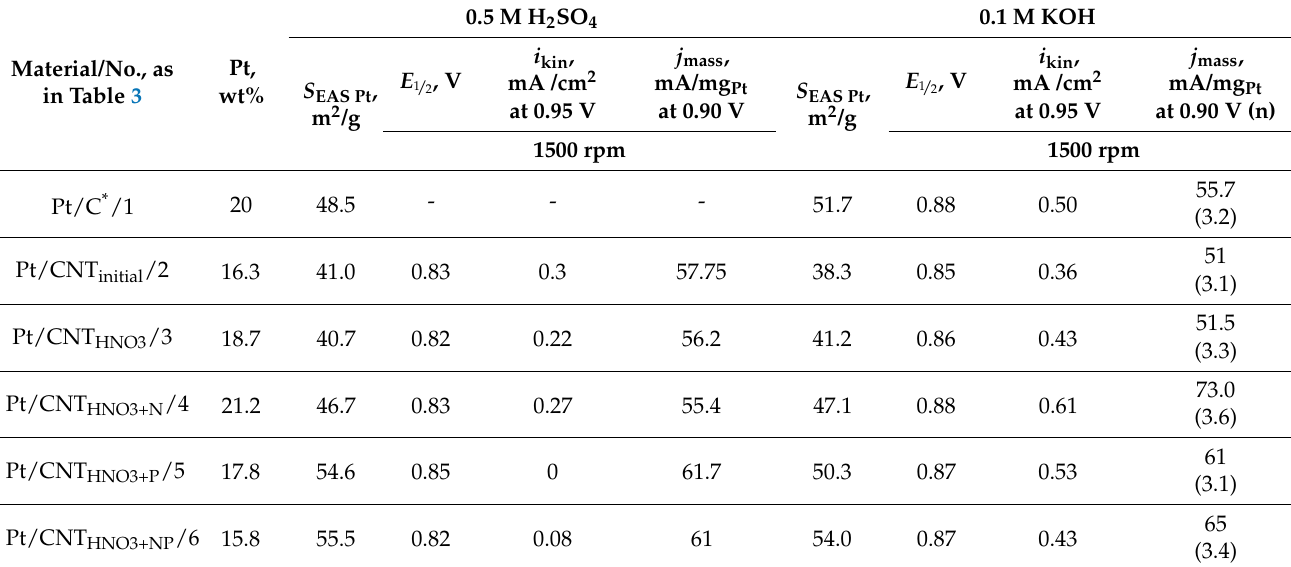
Table 4. Electrochemical characteristics of monoplatinum catalysts in acidic and alkaline electrolytes.